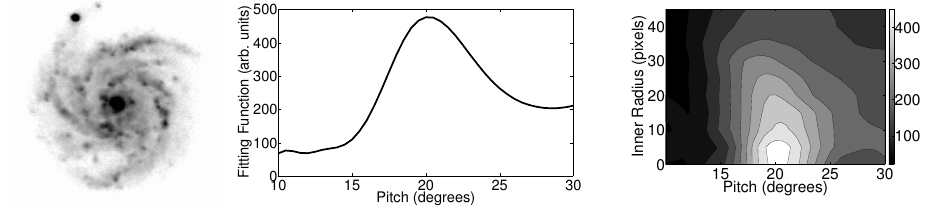
Figure 4. Spirality’s measurement of the galaxy UGC 463, ( B -band, Kitt Peak 2.1 m) shown in the left panel . Center : Fitting function vs. pitch angle for a measurement annulus with inner radius 5 pixels, or 4% of the galaxy’s visible radius. The outer radius of the measurement annulus is 115 pixels, or 96% of the galaxy’s visible radius. Right : Fitting function vs. pitch angle and measurement annulus inner radius. Note that the center panel is a cross section of the right panel. Spirality’s measurement gives a best-fit pitch of 19.85 ◦ ± 1.57 ◦ , which is consistent with 2DFFT’s measurement of 22.38 ◦ ± 3.21 ◦ . Spirality’s measurement gives a best-fit pitch of 19.85 ◦ ± 1.57 ◦ . For